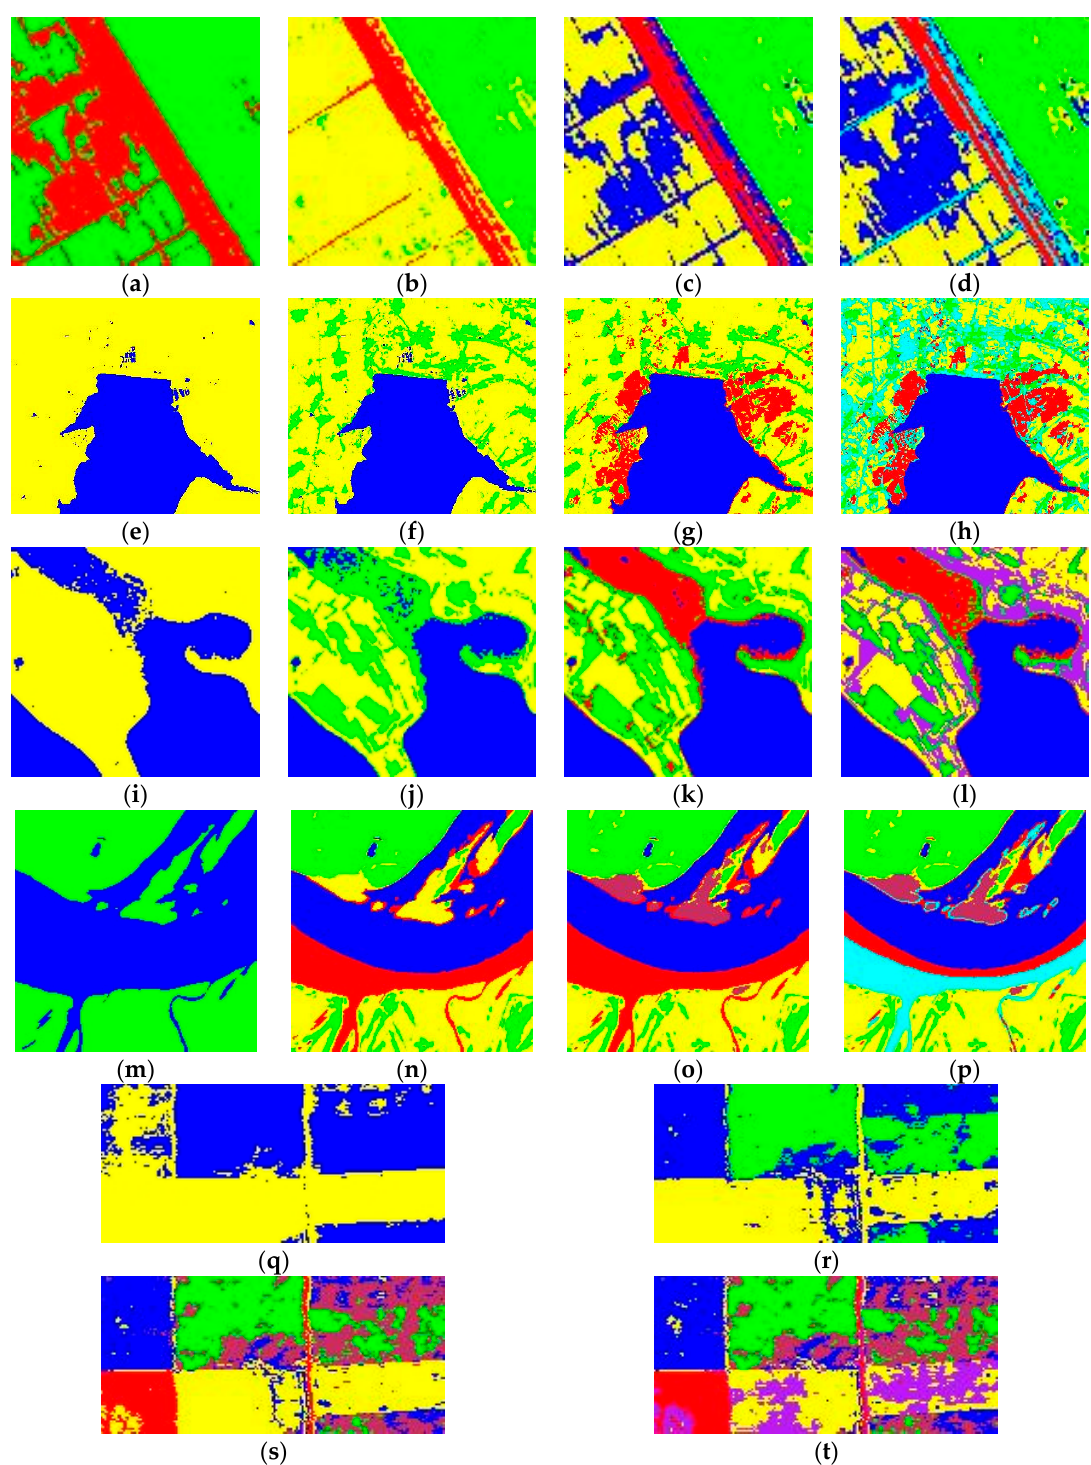
Figure 3. Clustering results of the multispectral images (each color represents a cluster). ( a ) QuickBird, K = 2; ( b ) QuickBird, K = 3; ( c ) QuickBird, K = 4; ( d ) QuickBird, K = 5; ( e ) Landsat TM, K = 2 ; ( f ) Landsat TM, K = 3; ( g ) Landsat TM, K = 4; ( h ) Landsat TM, K = 5; ( i ) Landsat ETM+, K = 2; ( j ) Landsat ETM+, K = 3; ( k ) Landsat ETM+, K = 4; ( l ) Landsat ETM+, K = 5; ( m ) GaoFen-1, K = 2 ; ( n ) GaoFen-1, K = 4; ( o ) GaoFen-1, K = 5; ( p ) GaoFen-1, K = 6; ( q ) FLC1, K = 2 ; ( r ) FLC1, K = 3 ; ( s ) FLC1, K = 5; and ( t ) FLC1, K = 6.